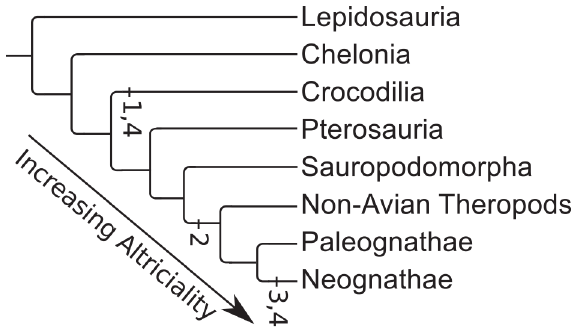
Fig 7. Summary of diapsid reproductive ecology evolution. The root of the tree shows no care, superprecocial offspring and polygamy of both sexes. 1 = transition to maternal care, 2 = transition to paternal care, 3 = transition to biparental care, 4 = transition to social